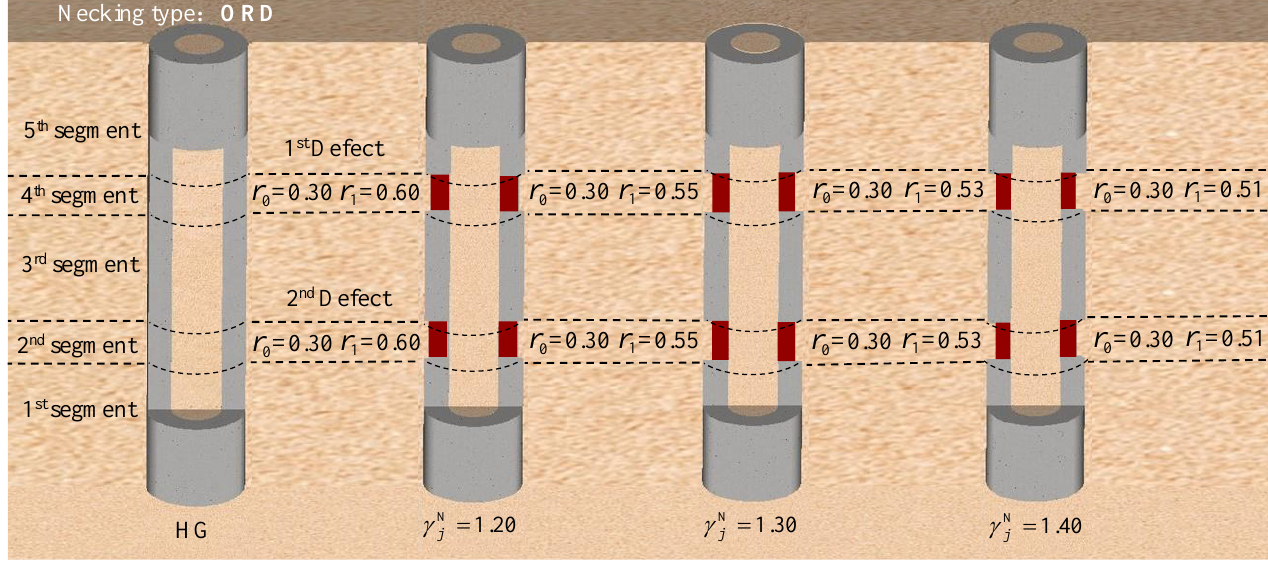
Figure 5. Diagram of necking degree.